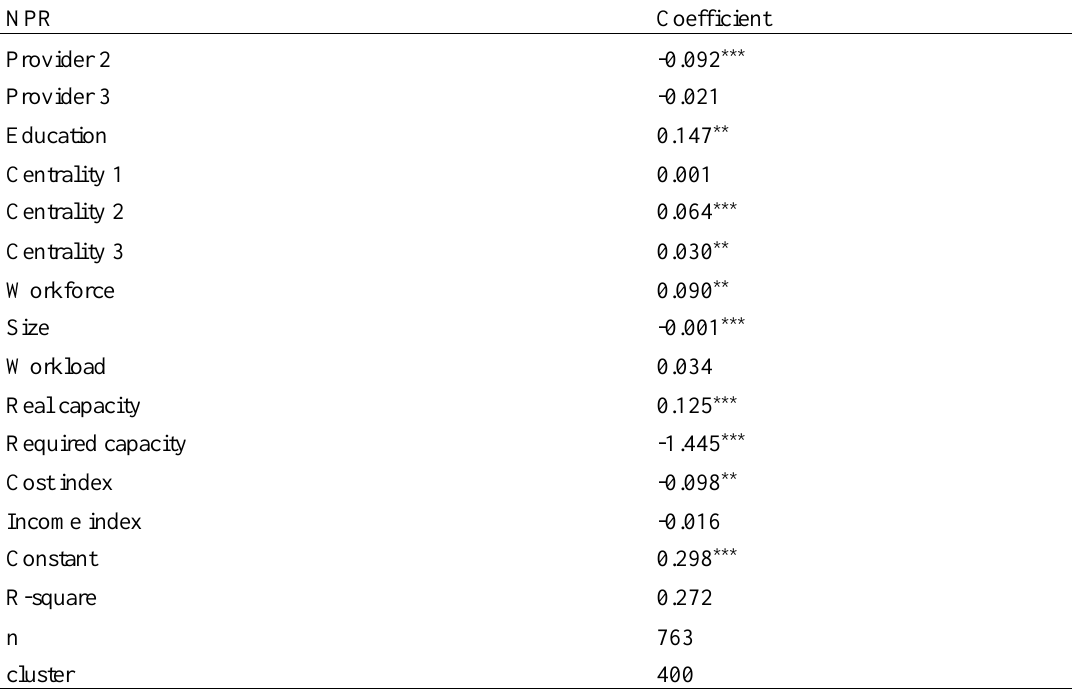
Regression of quality of care on provider categories and control